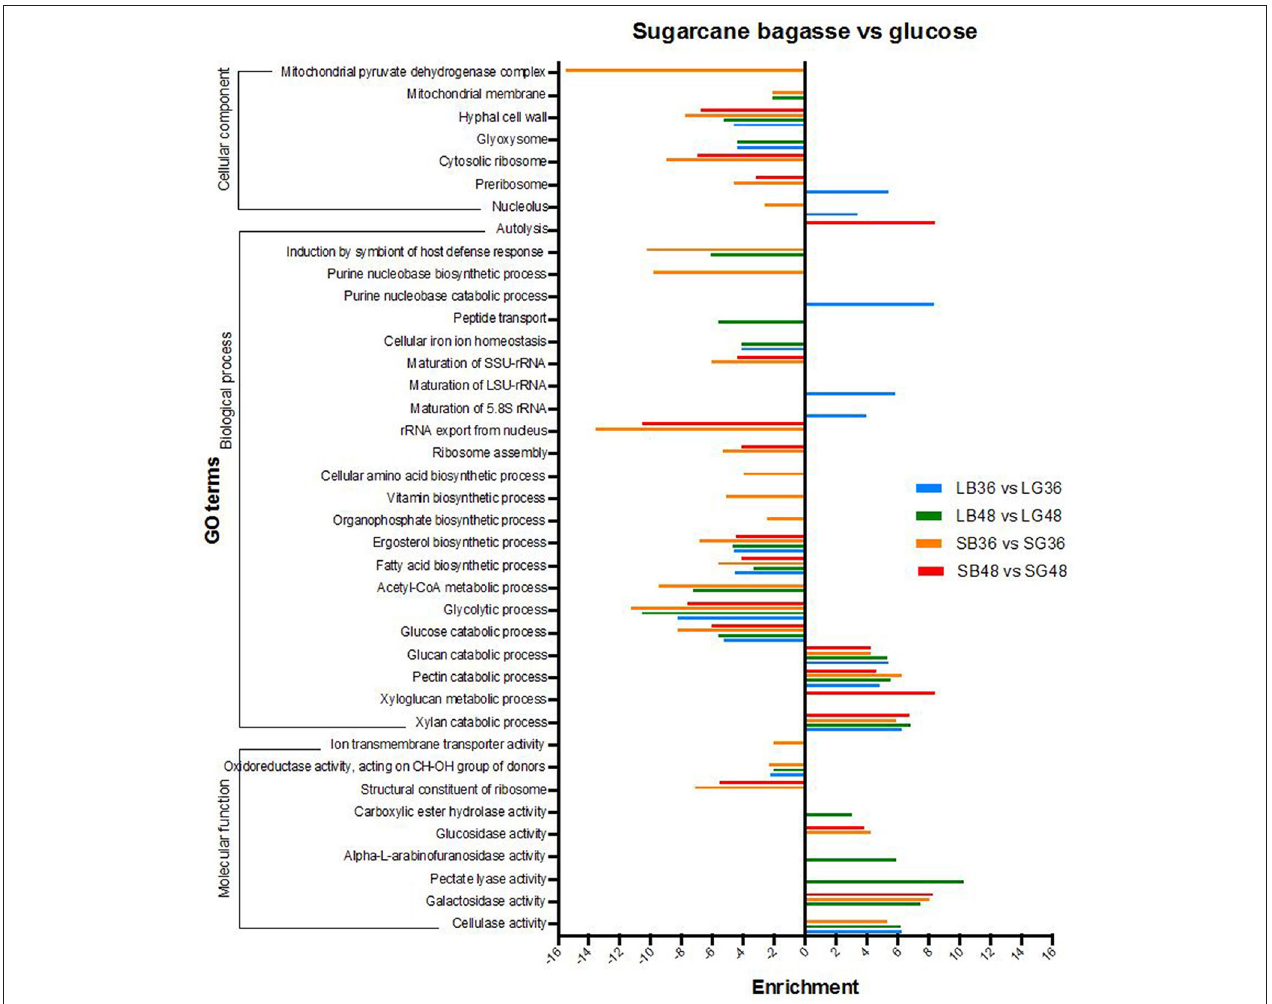
FIGURE 4 | Gene ontology (GO) enrichment analysis of differentially expressed genes in A. tamarii BLU37 following growth on steam-exploded sugarcane bagasse (SB) compared with glucose-supplemented treatments. Parameters comprising a cut-off False Discovery Rate (FDR) of 0.0%, a corrected P -value of < 0.05 and enrichment of > 2 and < − 2 were employed for consideration of DEGs between the compared growth